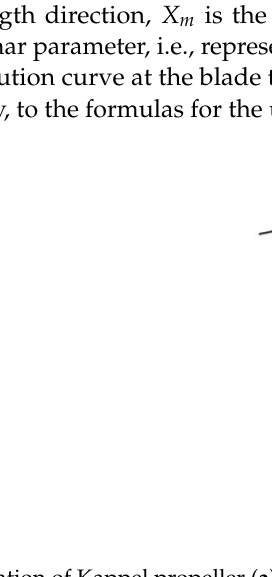
Figure 1. Blade geometry notation of Kappel propeller ( a ) and the notation of parameter ψ ( b ).